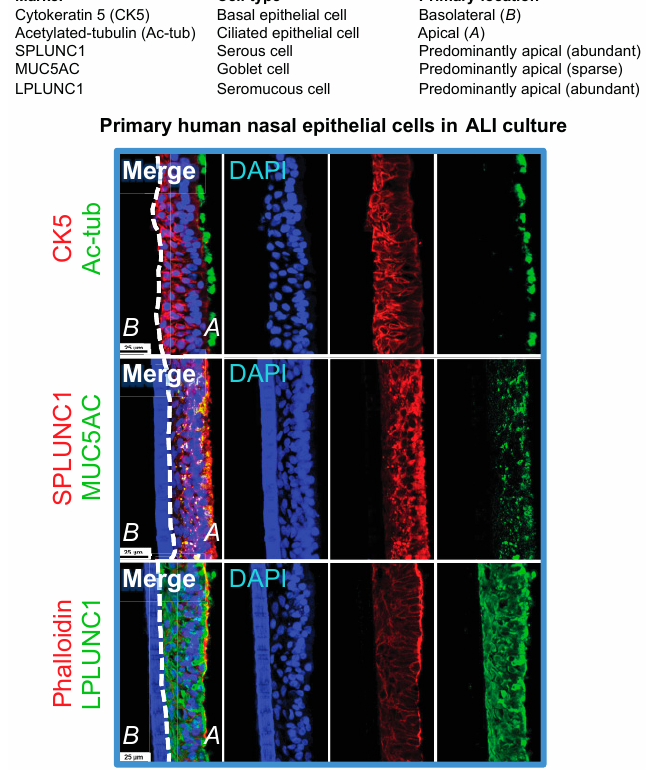
Figure 1. Confocal images of primary human nasal epithelial air-liquid interface (ALI) culture cryosections immunostained for cellular markers. Images were acquired on a Nikon A1 point scanning confocal microscope, processed with NIS Elements, and Z-stack 3D renderings are projected in the x-y plane.